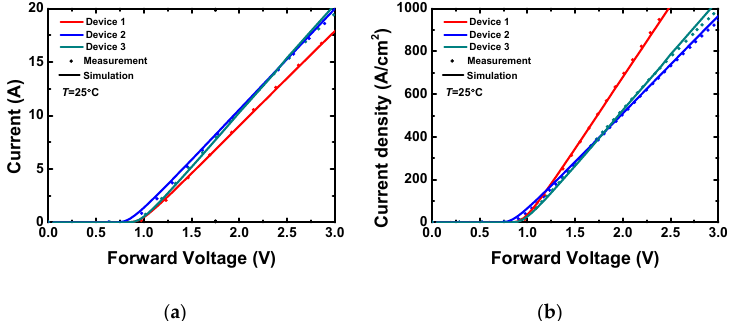
Figure 4. Simulated and measured forward characteristics of the three devices: ( a ) low current–voltage (I–V) curves, ( b ) low current density–voltage (J-V) curves.